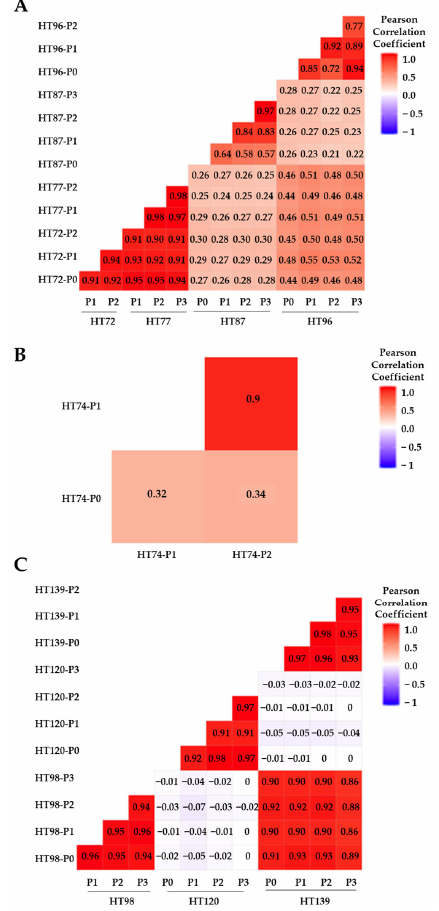
Figure 1. Analysis of congruence in total genes containing CNVs in the original P0 tumor and corresponding PDX passages. Heatmap shows PPCC scores for CNVs in P0 tumors and serial passages of ( A ) OS PDXs HT72, HT77, HT87, HT96, ( B ) RMS PDX HT74, and ( C ) PDXs for Wilms tumors HT98, HT120, and